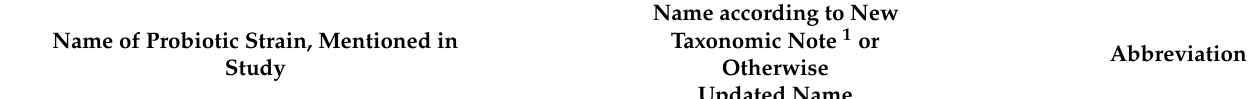
Table 3. Commercial names, manufacturing information of used probiotics and updated names according to new taxonomic nota.